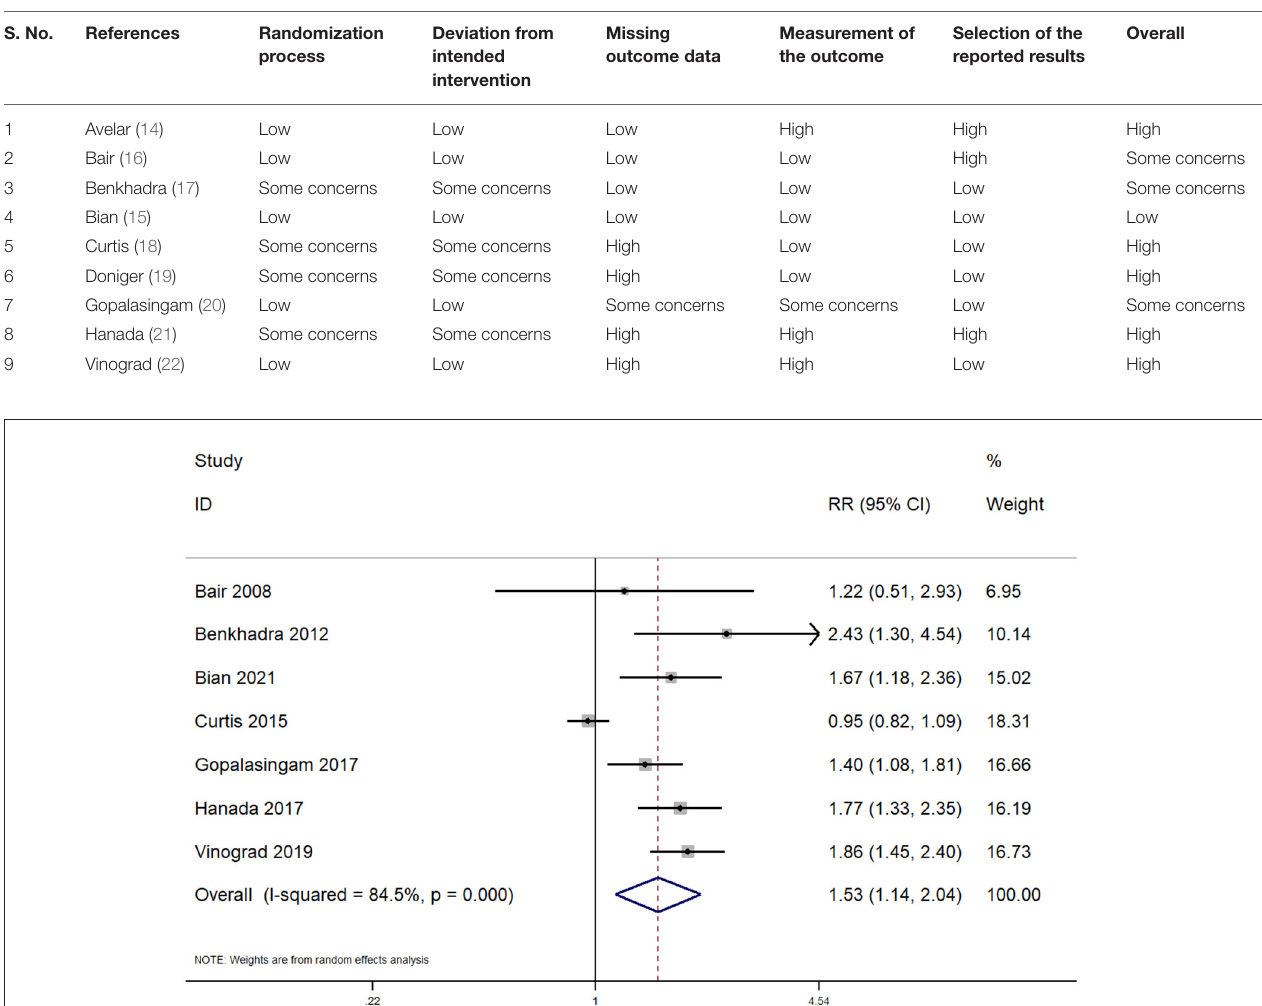
TABLE 2 | Risk of bias assessment N = 9. S.